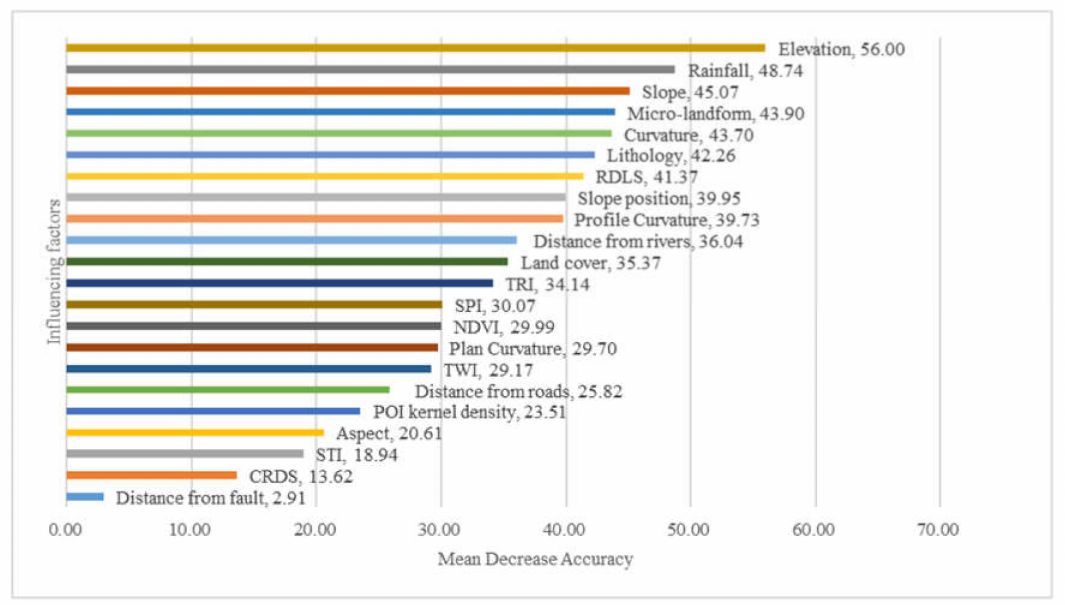
Figure 19. Mean decrease accuracy (sorted in descending order from top to bottom) of attributes, as assigned by the RF.